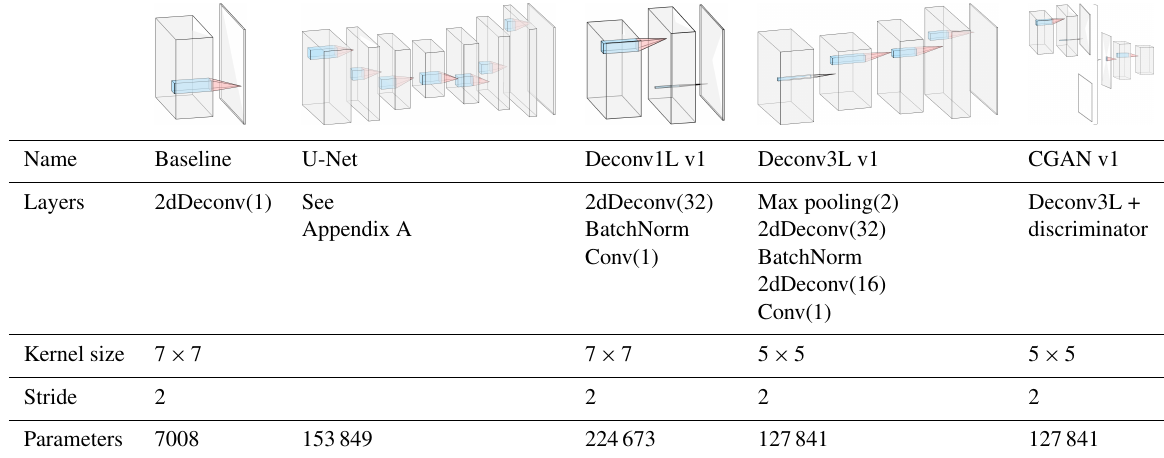
Table 1. Summary of the deep learning models trained and tested in this